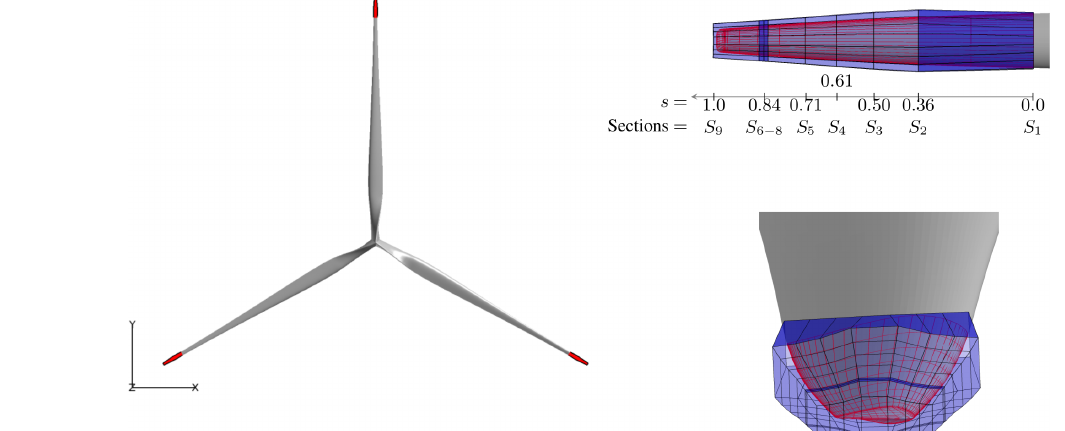
Figure 7. Overview of baseline rotor (gray), deformable tip region (red), and FFD boxes (blue). Grid level 3 is used to visualize mesh lines.